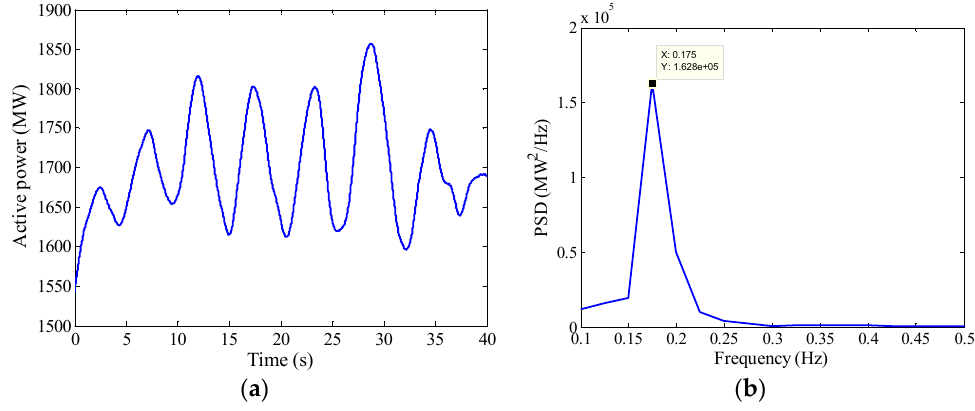
Figure 3. Properties of the UHV tie line oscillation of 40 s in both time and frequency domains. ( a ) Measured oscillation curve; ( b ) Corresponding PSD.